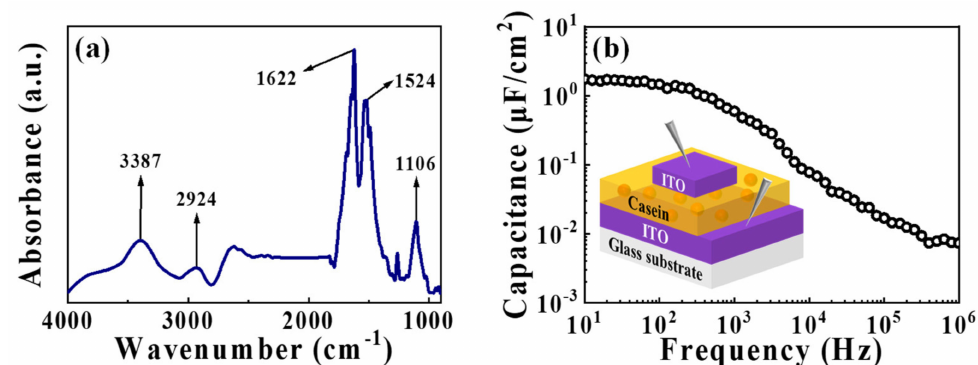
Figure 2. ( a ) Fourier transform infrared spectroscopy (FT-IR) spectrum of the casein electrolyte film. ( b ) Capacitance-frequency (C- f ) curve of the metal-insulator-metal (MIM) structured capacitors (indium-tin-oxide (ITO)/casein electrolyte-based